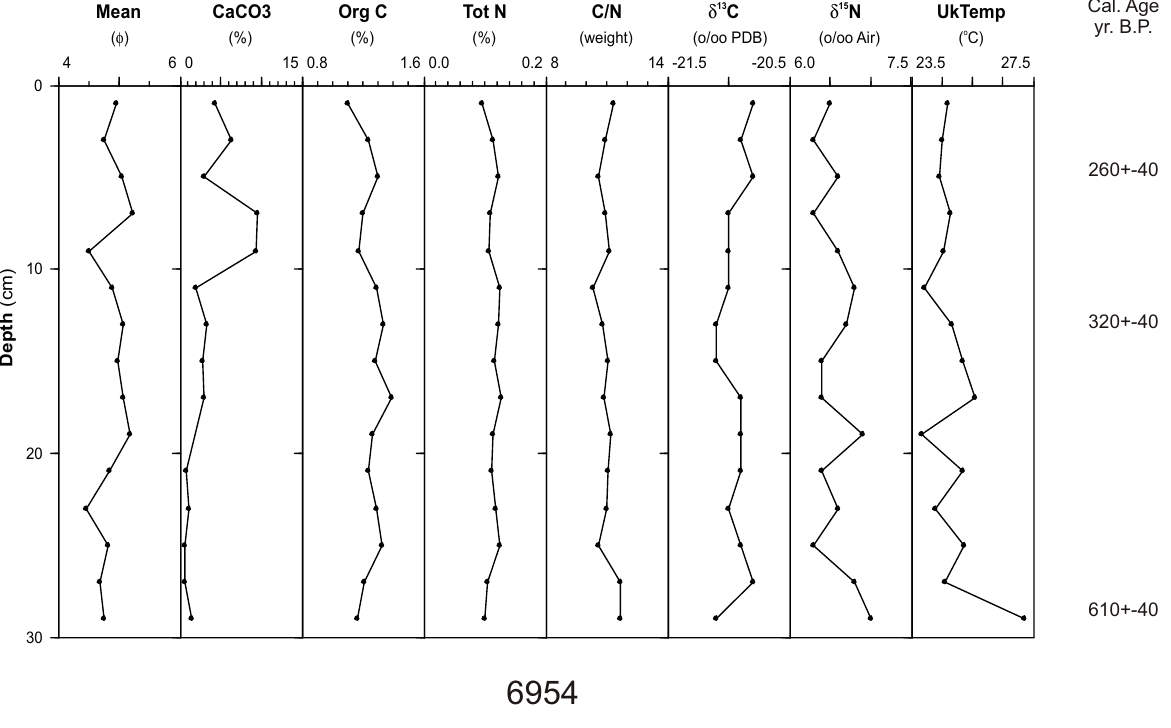
Fig. 7 – Mean grain-size, compositional, isotopic, and paleotemperature variations along core 6954.